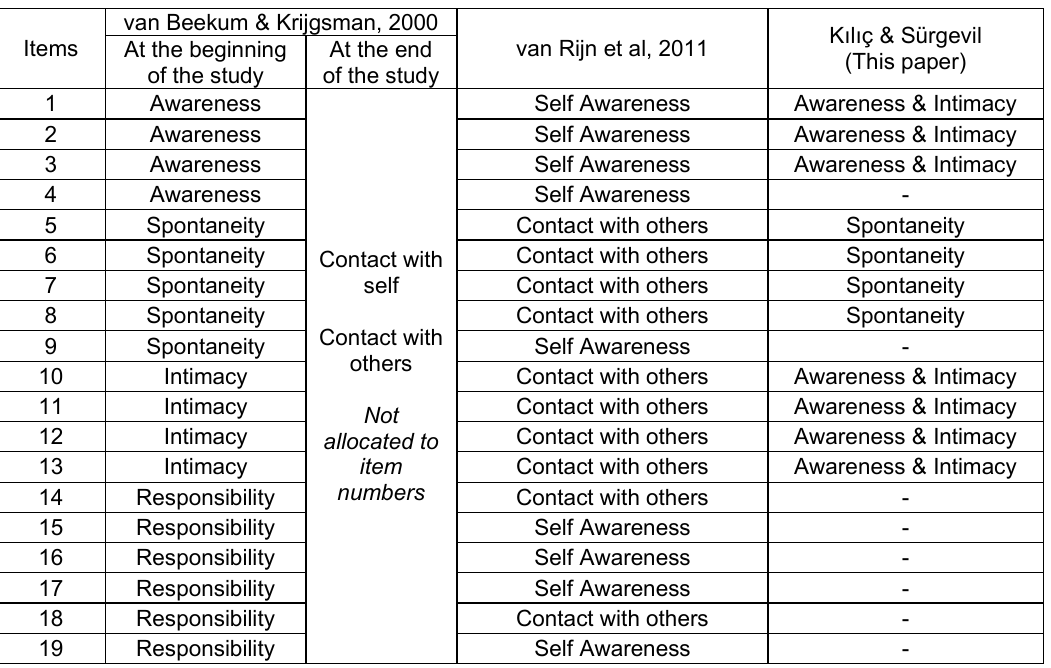
Table 1: Dimensions of Autonomy Scale (Van Beekum & Krijgsman, 2000, Van Rijn Et Al, 2011, Kılıç & Sürgevil)